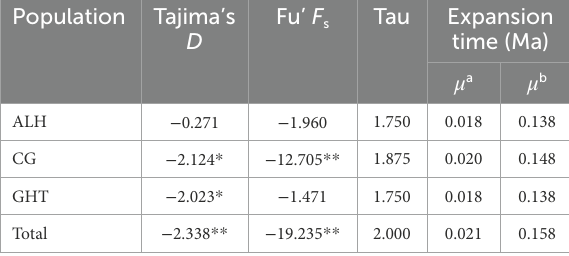
TABLE 5 Neutrality test and estimation of expansion time for Jankowski’s Bunting. Population